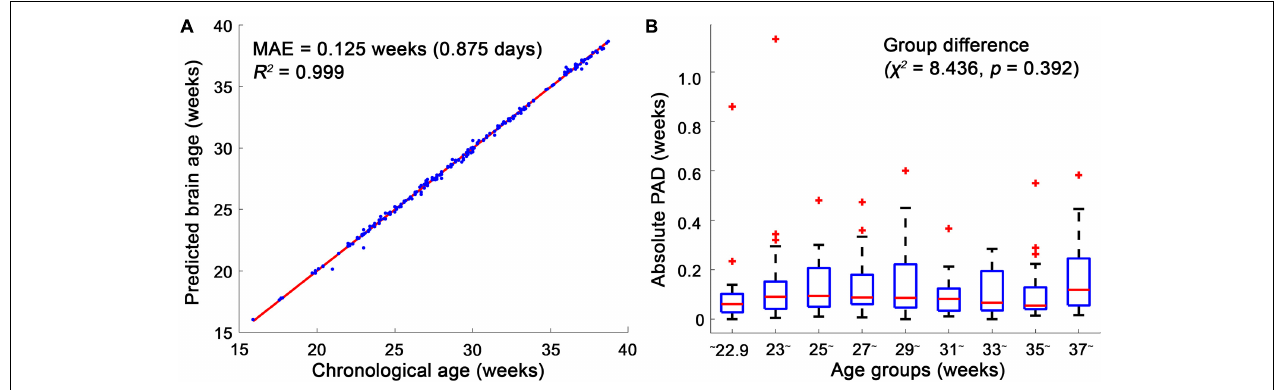
FIGURE 4 | Linear regression model between the chronological age and brain age and box plots of the absolute predicted age differences (PADs) in the age groups. (A) The mean absolute error (MAE) between the chronological and brain ages was 0.125, and their regression coefficient ( R 2 ) was 0.999. (B) Among the age groups, no significant difference in the absolute PADs was found in the Kruskal–Wallis test. In each age group, the red horizontal line indicates the median of the absolute PADs, and the bottom and top edges of the box represent the lower quartile and upper quartile of the absolute PADs. The outliers (red crosses) represent the values that fall outside of the lower or upper boundaries between 1.5 times of the interquartile range, respectively. The black horizontal lines display the boundaries.